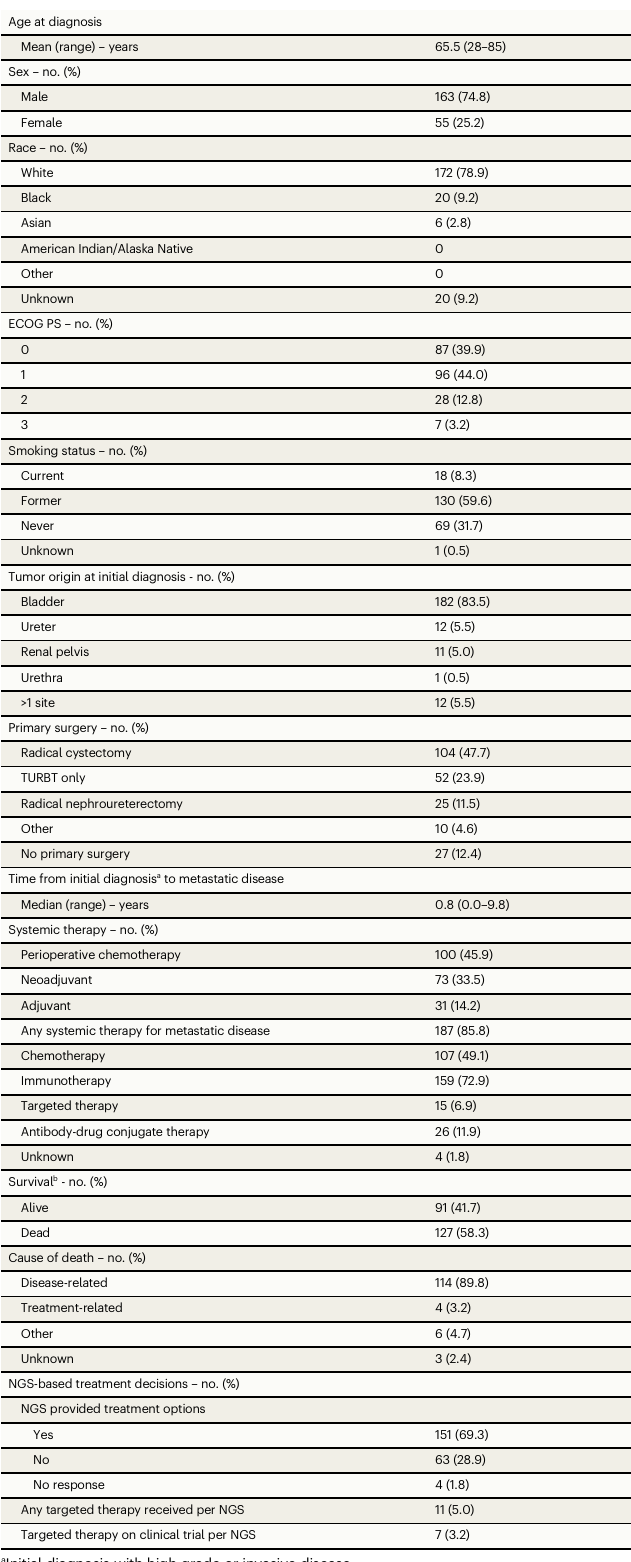
Table 1 | Demographic, clinical characteristics and NGS- based treatment ( n = 218) Ageatdiagnosis Mean(range) –